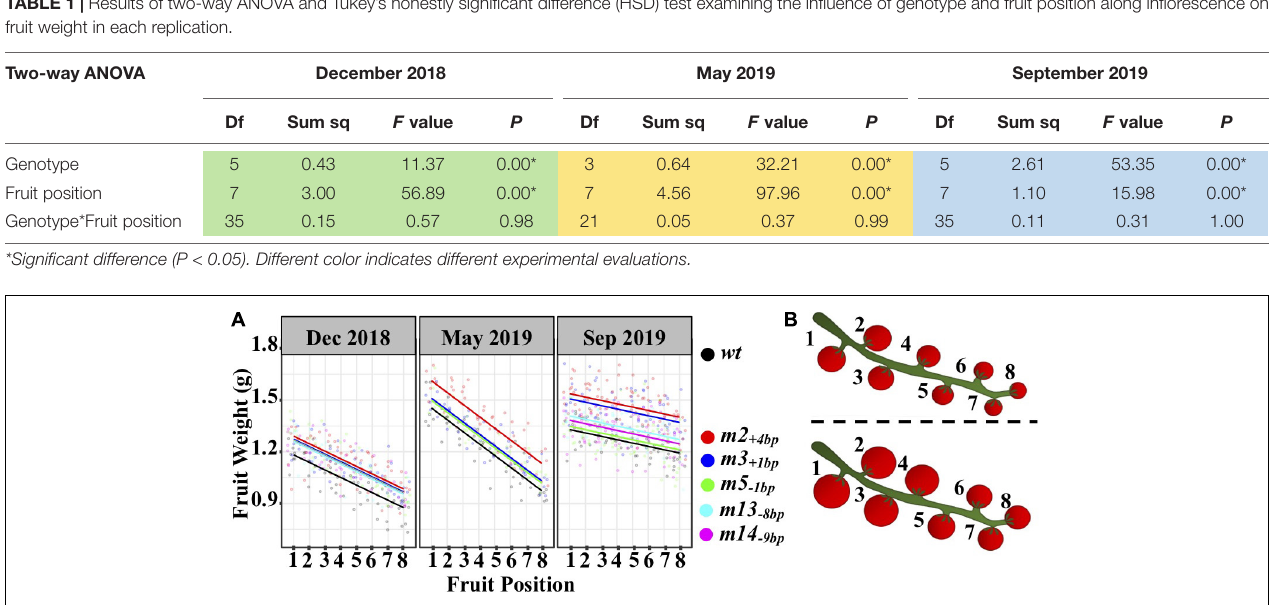
FIGURE 4 | The effects of genotype and fruit position on fruit weight. (A) Linear regression between fruit weight and fruit position. Because the interaction of genotype and fruit position had no significant effect, the slopes of the regression lines are equal; in other words, the regression lines are parallel to each other in each replicate. Each data point is the mean fruit weight of each fruit position in one plant; (B) Schematic diagram shows the increased fruit weight along inflorescence in the mutants (lower panel) compared to LA1589 (upper